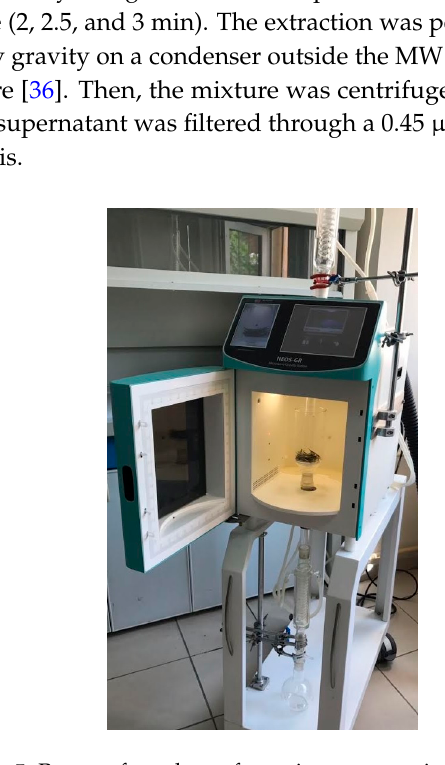
Figure 5. Reactor for solvent-free microwave-assisted extraction.